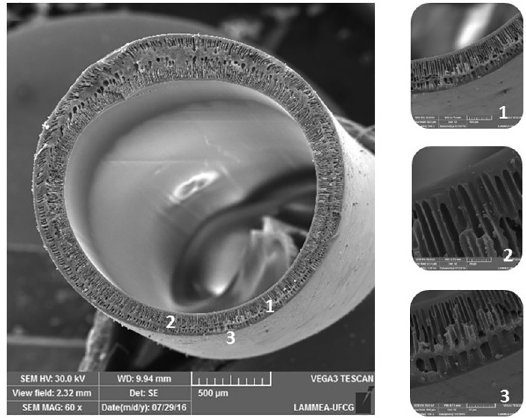
Figure 6 . SEM photomicrographs of PES hollow fiber membrane.